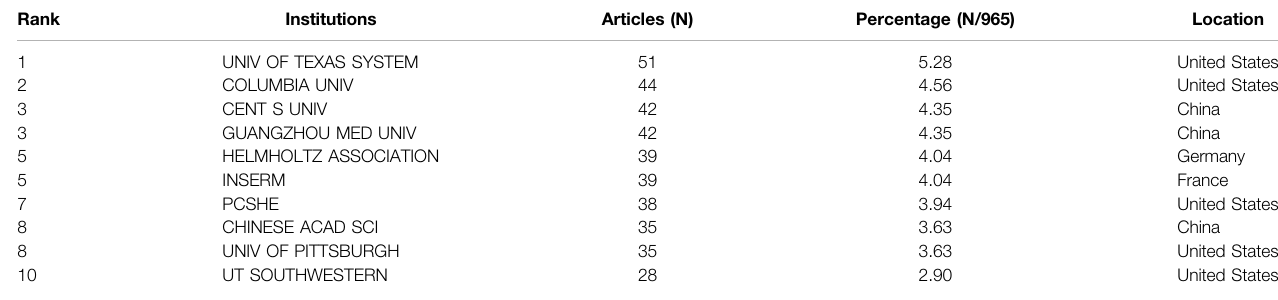
TABLE 2 | Top 10 productive institutions related to ferroptosis in cancer